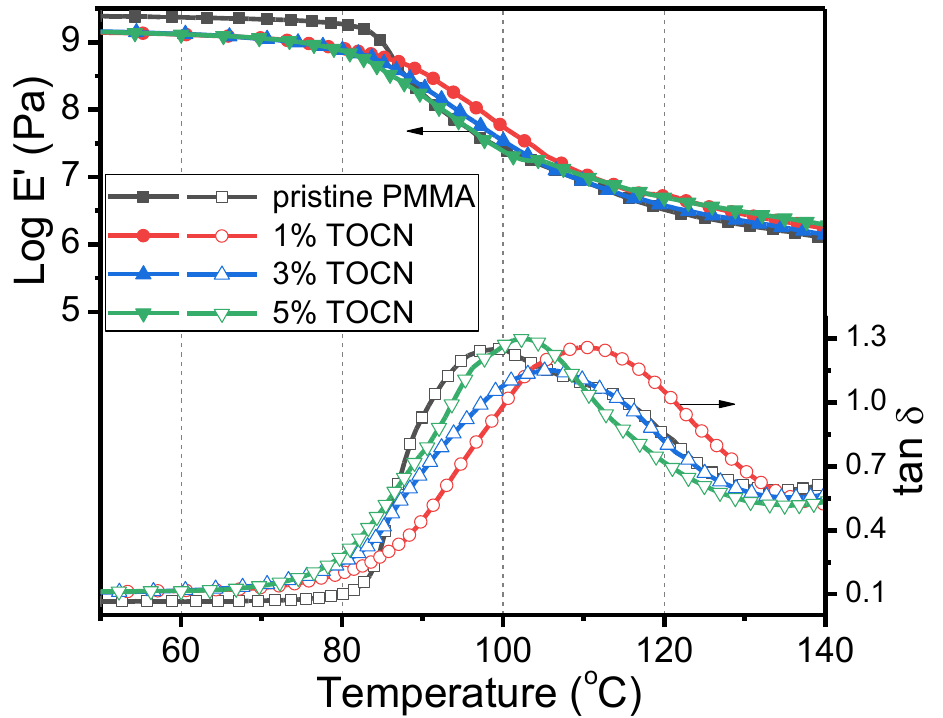
Figure 10. Dynamic mechanical analysis (DMA) traces of (squares) PMMA and (circles, up-, and down-triangles) composites ( E ’: solid symbols; tan δ : hollow symbols).